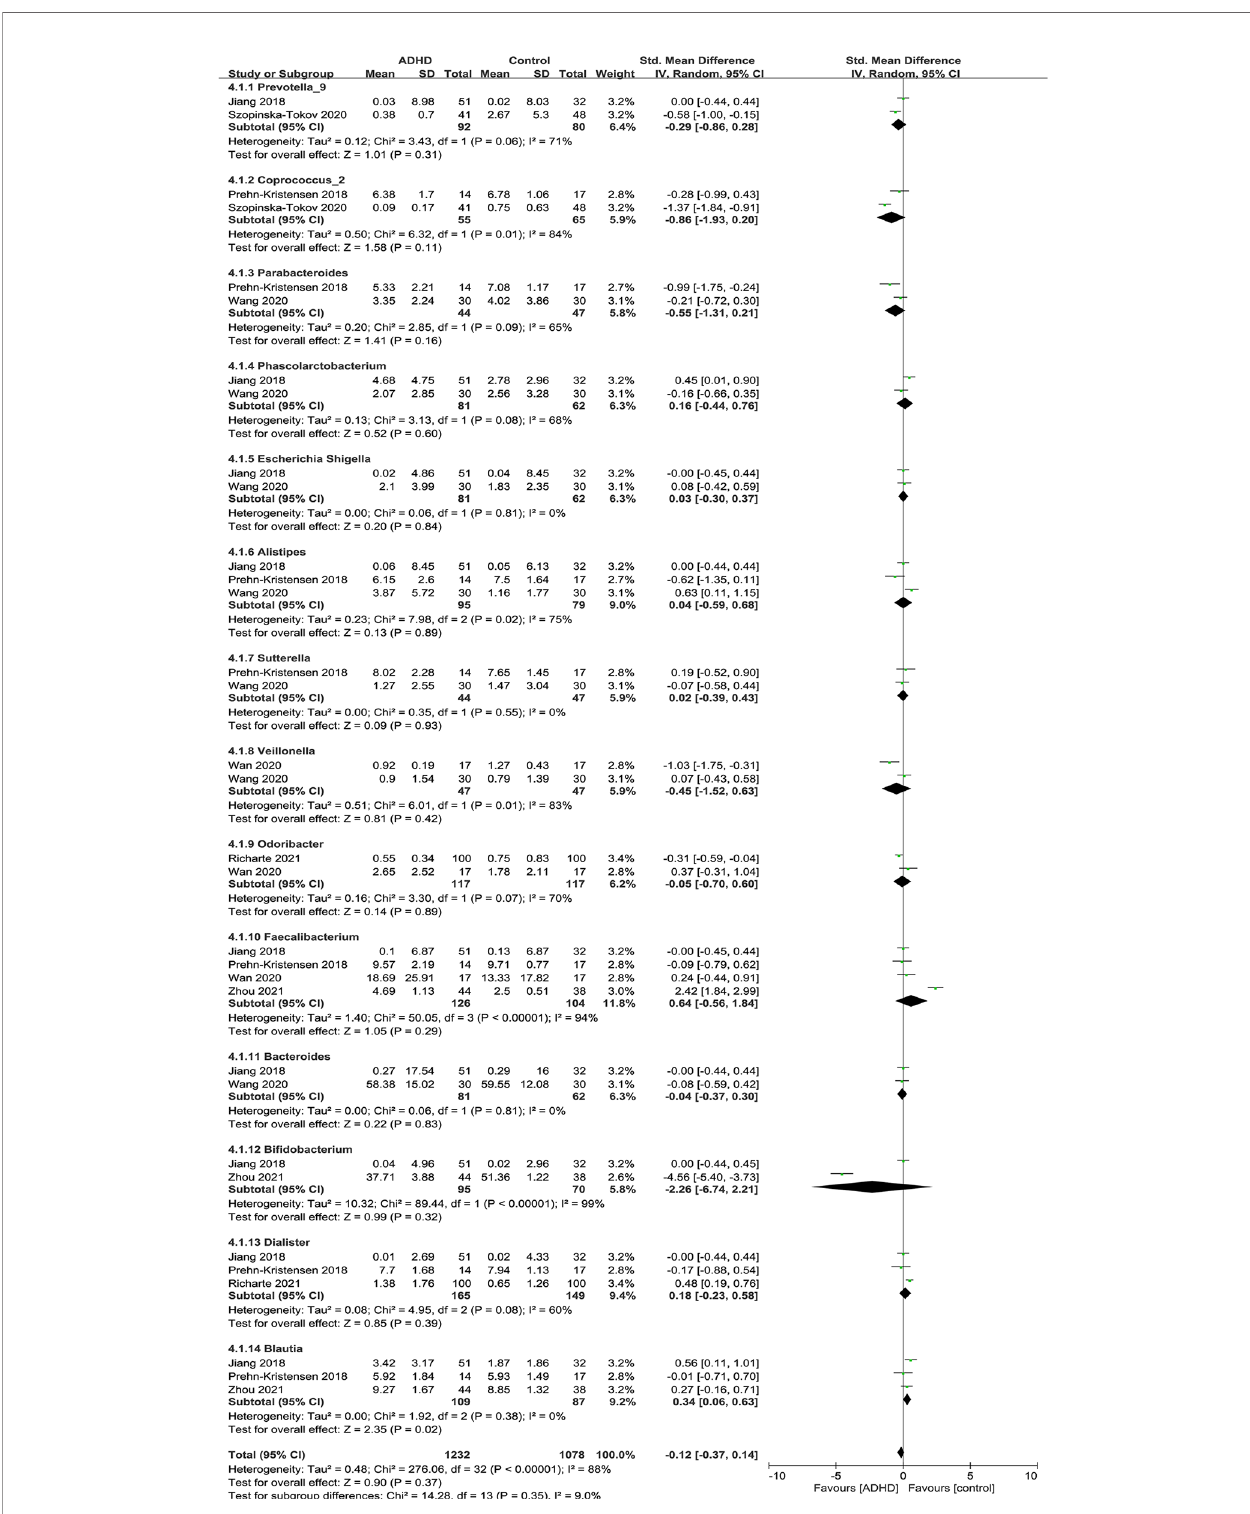
Frontiers in Endocrinology |